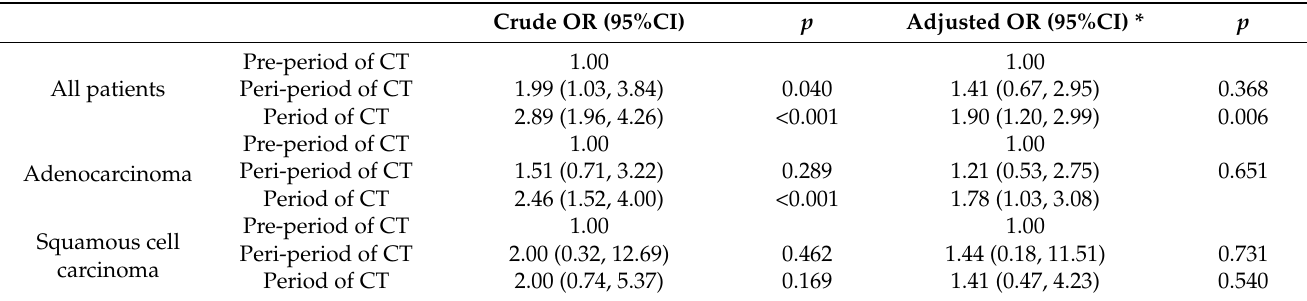
Table 5. Multivariate analysis for early detection of lung